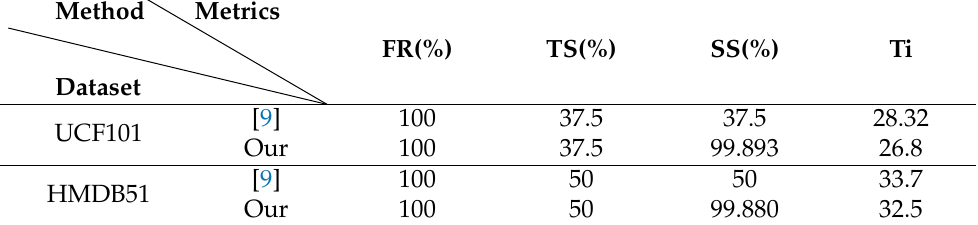
Table 4. Results of LRCN model on UCF101 and HMDB51 datasets in white-box setting.